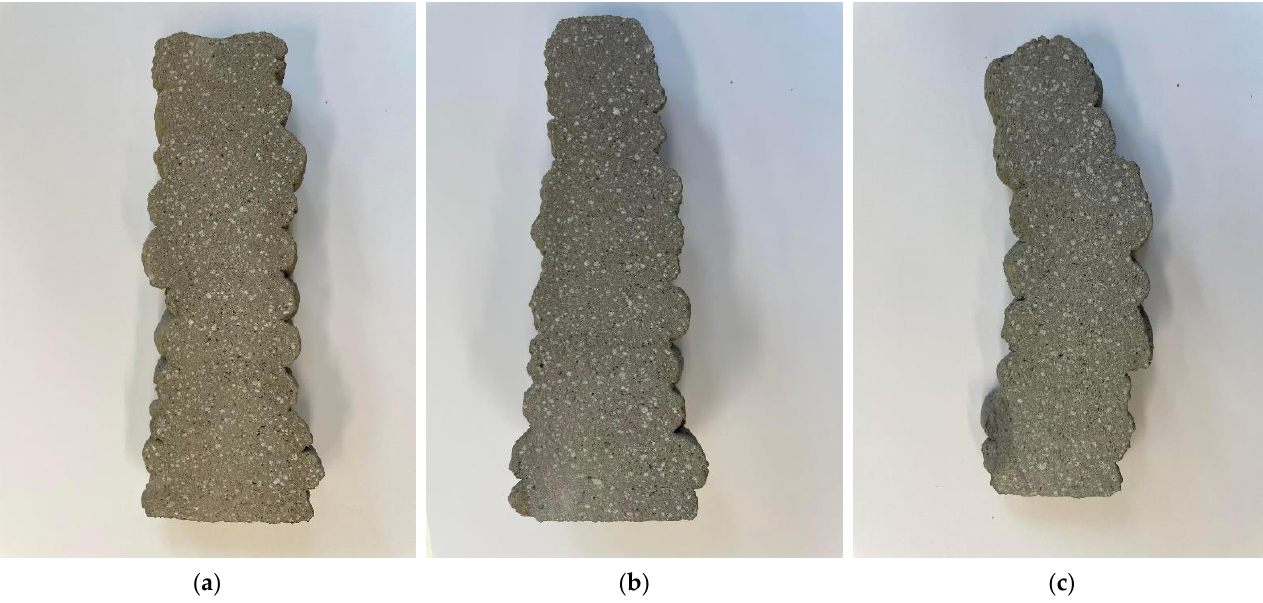
Figure 14. Cross sections of hardened 3D printed specimens ( a ) mixture SAP_35HFA ( b ) mixture SAP ( c ) mixture C_C. SAP ( c ) mixture